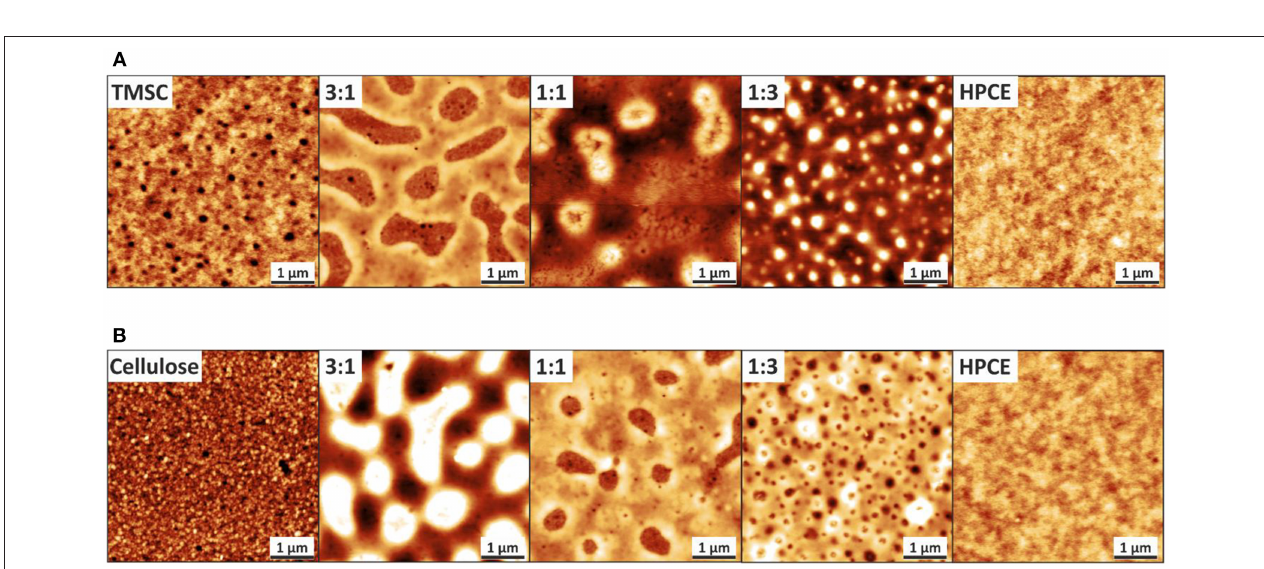
FIGURE 2 | AFM topography images of (A) TMSC:HPCE and (B) cellulose:HPCE blend films. The z-scale for the neat films is 10nm and for all the blend films 60 nm. The z-directional height increases with increasing brightness.